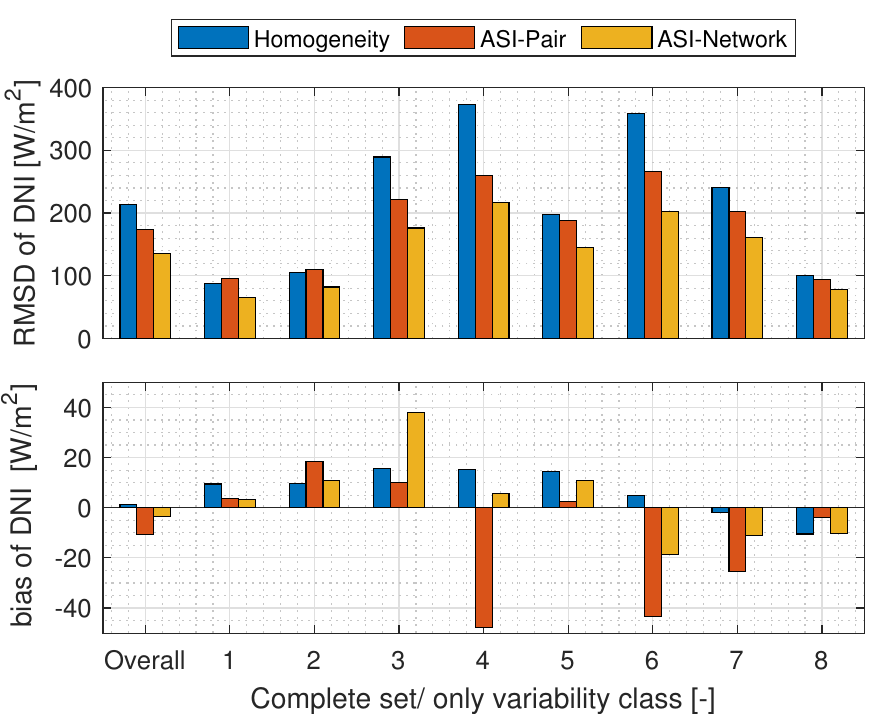
Figure 10. This figure shows deviation metrics RMSD and bias for the tested approaches to analyze DNI (homogeneous persistence, blue; ASI pair, red; and ASI network, yellow). The 92 day validation dataset (labeled overall ) and eight subsets distinguished by the DNI variability classes are evaluated separately. As summarized in Table 2, each variability class describes a specific sky